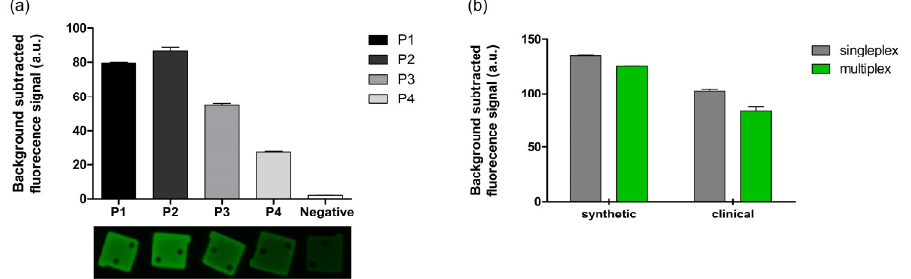
Figure 5. BREP assay with clinical samples. ( a ) Singleplex BREP assay with clinical sample of four patients with malaria. ( b ) Comparison of the results obtained after singleplex and multiplex assays with both synthetic DNA template and clinical samples from patients with malaria. Bar graph showing mean values of background subtracted from fluorescence signal intensity. Error bars represent standard deviation (n = 3).